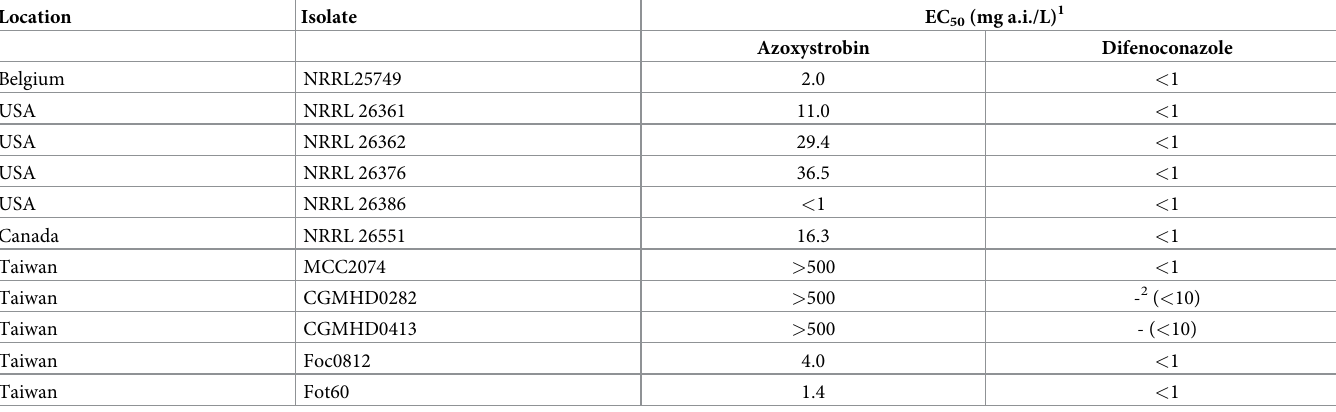
Table 6. Sensitivity of mycelial growth of HOFo isolates to azoxystrobin and difenoconazole.